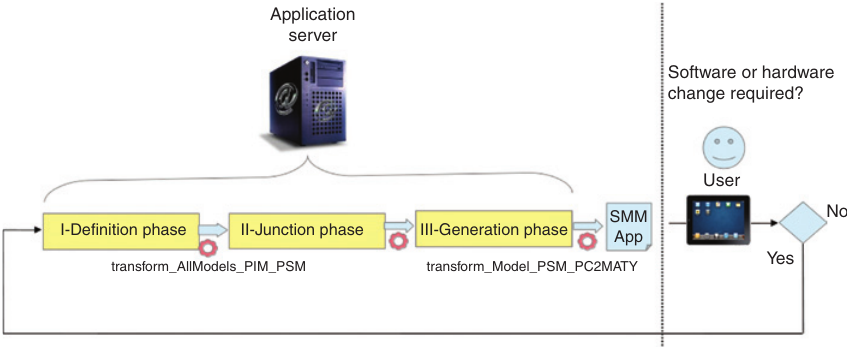
Figure 4: The Generator’s Application Design